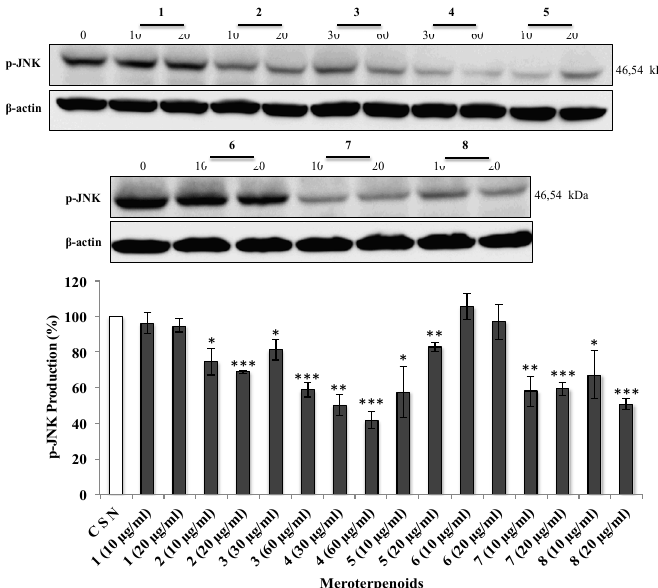
Figure 6. E ff ect of meroterpenes (AMTs) 1-8 on the activation of extracellular signal-regulated kinase (ERK) by measuring the expression levels of the phosphorylated form (p-ERK) in HT-29 cells. The cells were treated for 24 h with the compounds (10 and 20 µ g / mL for 1 , 2 , 5 , 6 , 7 , and 8 ; 30 and 60 µ g / mL for 3 and 4 ). The levels of p-ERK were measured by Western blot analysis and quantified with Image J analysis software. The result of control groups was set as 100% activity and test groups were compared to this value. The data shown are the means ± SE of three independent experiments. Significant di ff erences from control group: * p < 0.05 and *** p < 0.001. Foods 2020 , 9 , 300